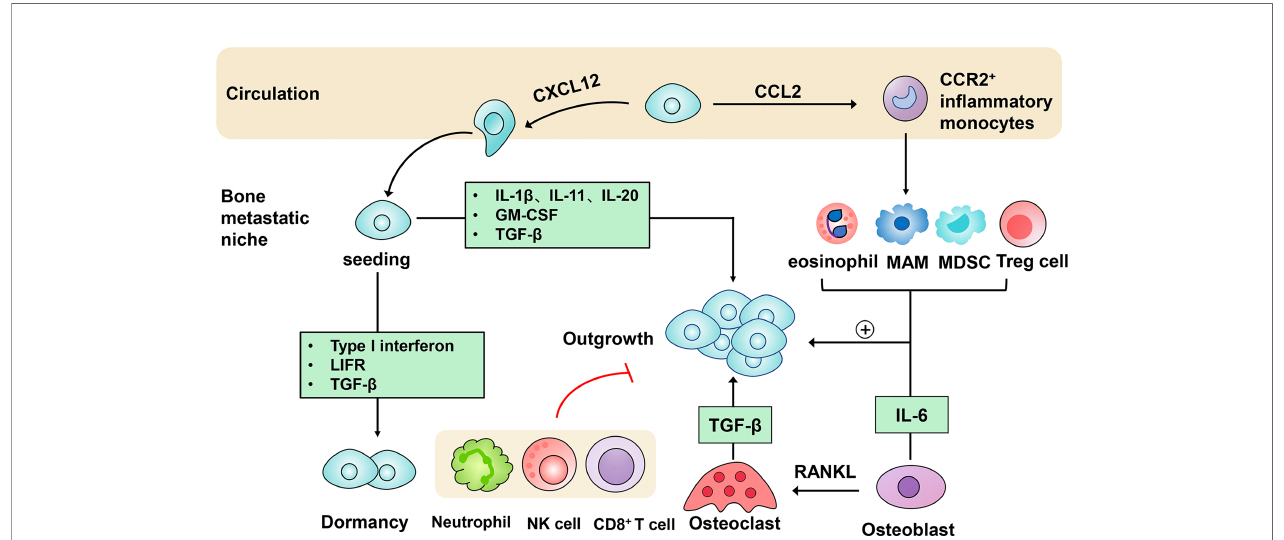
FIGURE 1 | Immune mechanisms in the progression of bone metastasis. After being detached from the primary tumor, circulating tumor cells produce CXC- chemokine ligand 12 (CXCL12) to facilitate metastatic homing to the bone. They can also secrete CC-chemokine ligand 2 (CCL2) to recruit CC-chemokine receptor 2 (CCR2) + in fl ammatory monocytes towards the bone metastatic niche, in which they differentiate into metastasis-associated macrophages (MAMs). Following metastatic seeding into the bone, disseminated tumor cells can remain in a dormant state driven by type I interferon, the receptor of leukemia inhibitory factor (LIFR), transforming growth factor- b (TGF- b ). Induced by several immune molecules, dormant tumor cells can be reactivated and initiate metastatic outgrowth. Eosinophils, MAMs, myeloid-derived suppressor cells (MDSCs), regulatory T cells (Tregs) conspire to support the persistent growth of metastatic tumor cells. Furthermore, the tumor-stroma interactions are engaged in the acceleration of bone metastasis. Osteoblasts-derived receptor activator of nuclear factor- k B-ligand (RANKL) induces the differentiation of osteoclasts, which in turn stimulates bone resorption and tumor cell proliferation mediated by growth factors like transforming growth factor- b (TGF- b ). In addition, immune cells including neutrophils, nature killer (NK) cells and CD8 + T cells act to restrict metastatic tumor cell